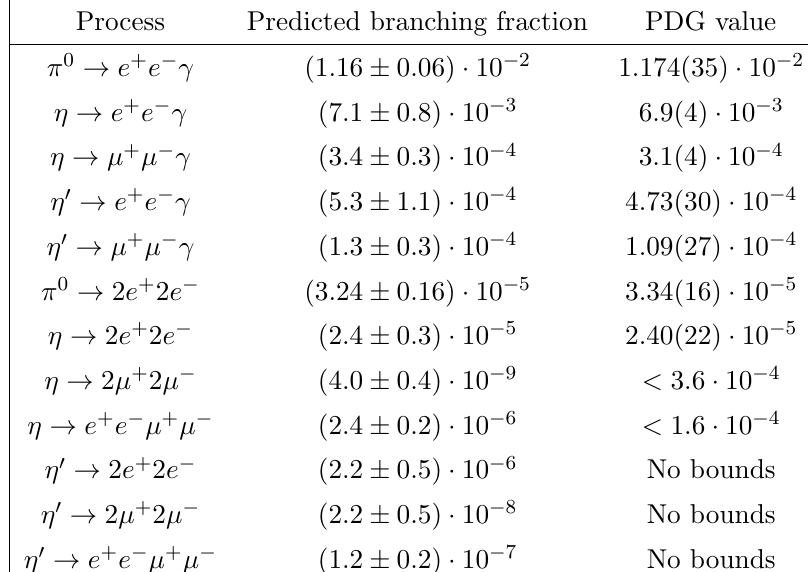
Table 12 . Predicted branching fractions of the (cid:12)tted parameters excluding BaBar (cid:25) 0 data com- pared to PDG data. PDG upper bounds are given at the 90 % con(cid:12)dence level.